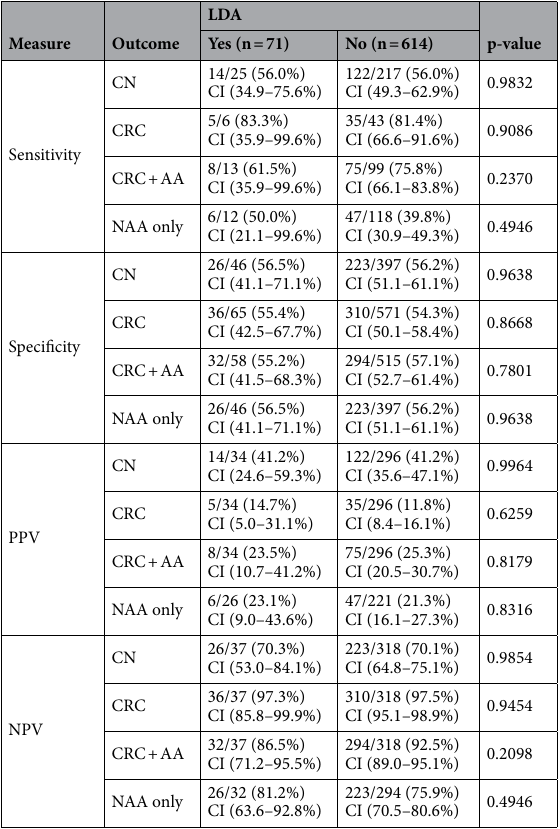
Table 4. Effects of low dose aspirin (LDA) on the results of fecal immunochemical test in colorectal neoplasms screening. CN colorectal neoplasms, CRC colorectal cancer, AA advanced adenoma, NAA non advanced adenoma, PPV positive predictive value, NPV negative predictive value, CI confidence